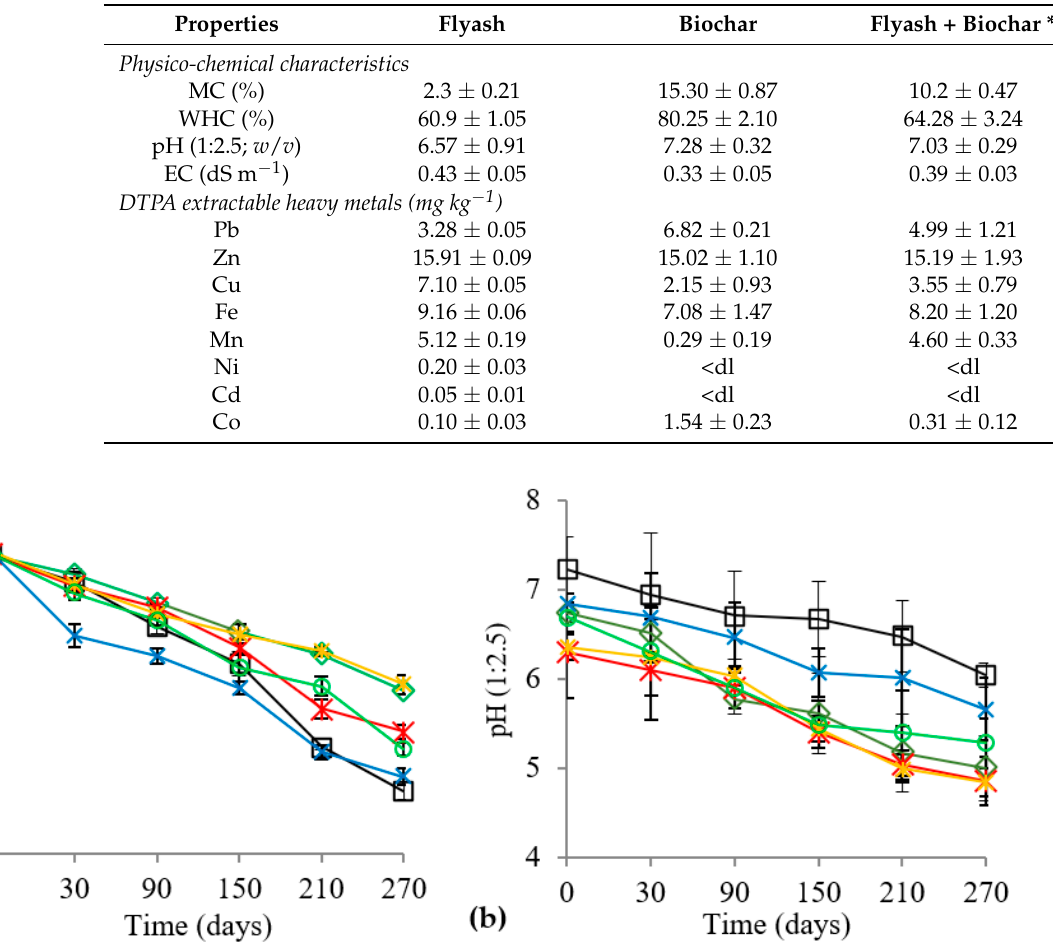
Figure 1. Changes in ( a ) logarithmic value of CFU g − 1 determined by plate-count method, ( b ) pH, and ( c ) moisture content of three biofertilizers (carrier with strain L2 and A30) during the different storage period. Mean ± SE ( n = 3). FA: flyash; BC: